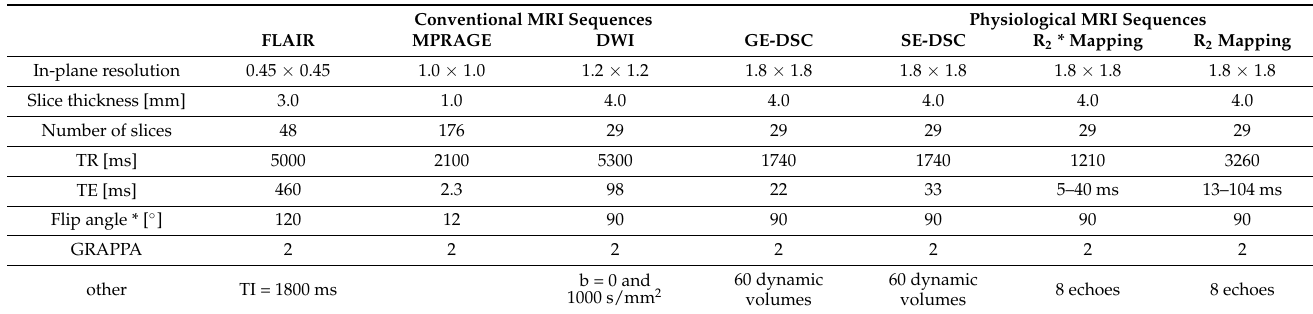
Table 1. Sequence parameters of the magnetic resonance imaging (MRI) study protocol. Conventional MRI Sequences Physiological MRI Sequences